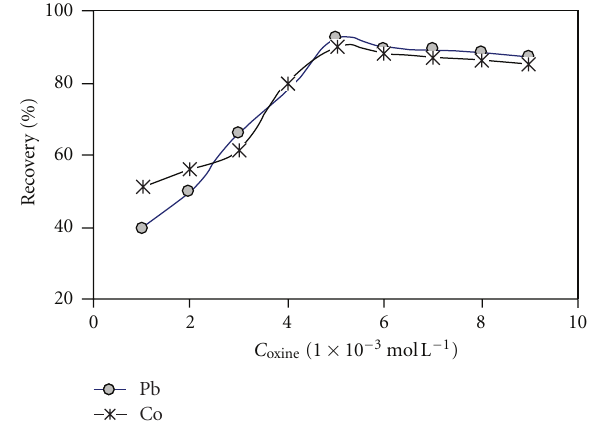
Figure 3: E ff ect of oxine concentration on the percentage of recovery: 20 µ g L − 1 of Pb and Co, 0.5% (v/v) Triton X-114, pH 7.0, temperature 50 ◦ C, and centrifugation time 10 min